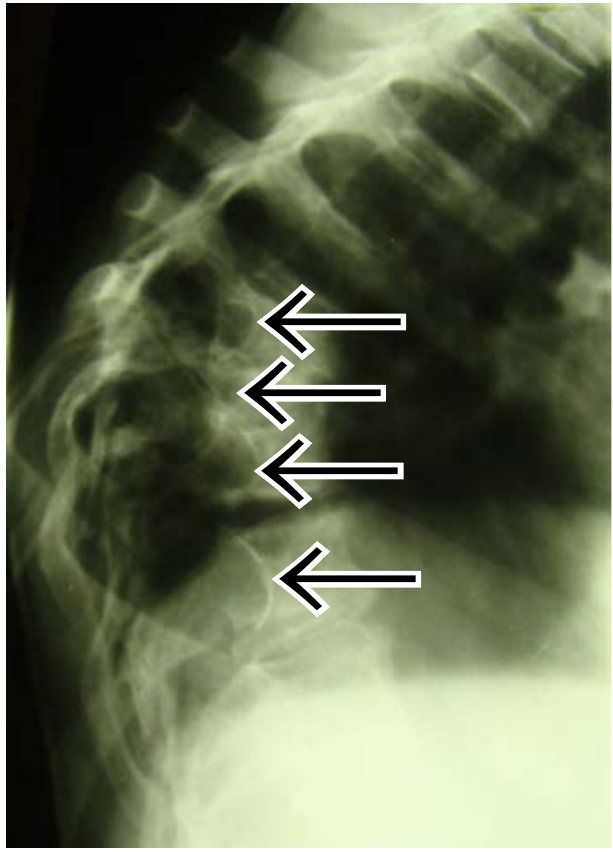
Fig. 8a. Lateral X-ray of the thoracic spine showing enlargement of the neural foramina at multiple levels and posterior vertebral scalloping gibbus owing to multiple dumbbell tumours and dural ectasia.